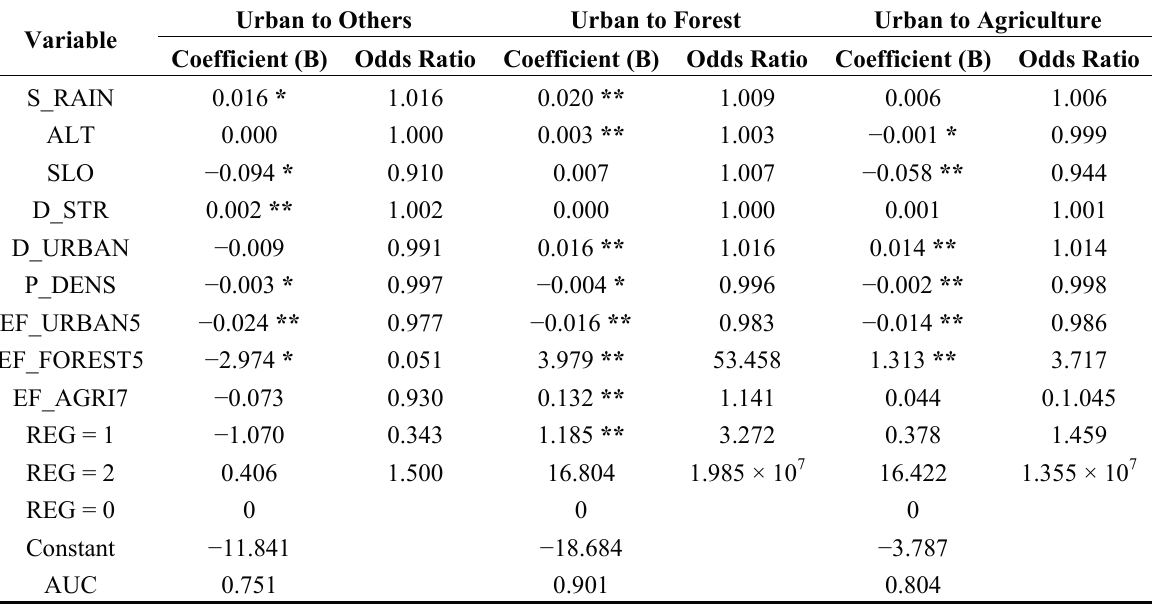
Table 4. Factors of urban land-use changes using logistic regression (1990~2000). Urban to Others Urban to Variable